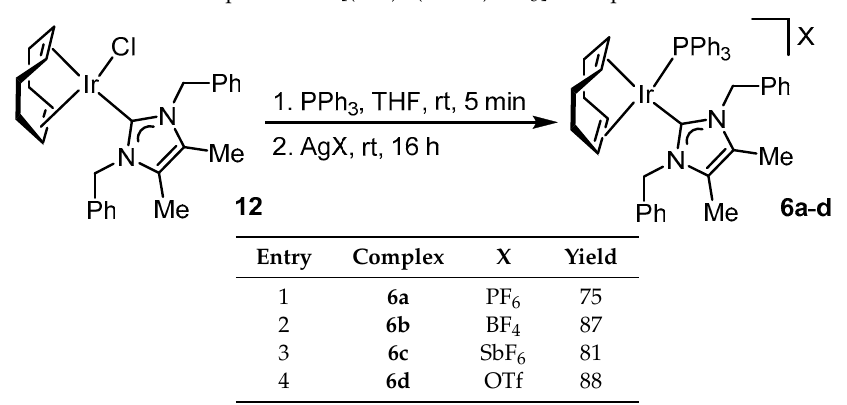
Table 1. Preparation of [(cod)Ir(IBn Me )PPh 3 ]X complexes 6a – 6d .